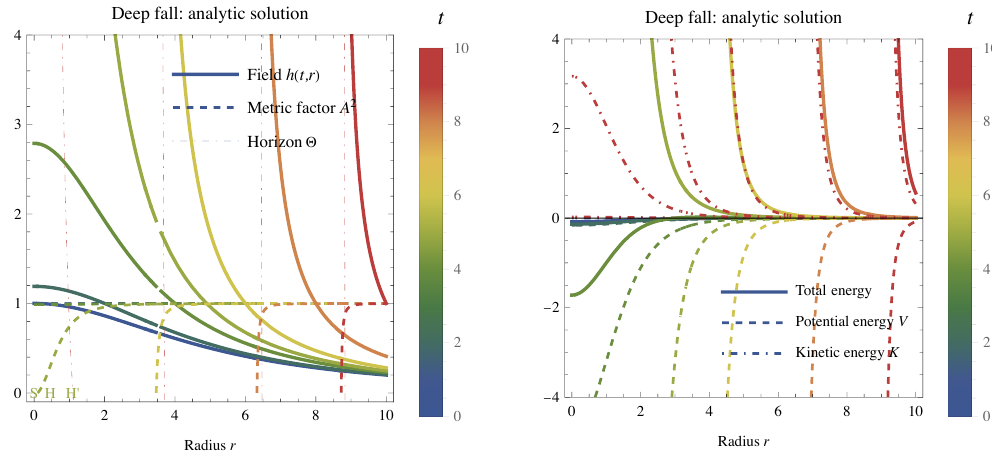
Figure 3 . Evolution in Einstein gravity of the scalar bubble for the potential of eq. (3.2). Left : the field h ( t, r ) , the scale factor A ( t, r ) , and the criterion for horizon formation Θ( t, r ) . An apparent horizon first appears at the point denoted as H. Later a singularity appears inside the horizon at the point denoted as S, while the horizon reaches H 0 . Right : the energy densities. We assumed ¯ h 0 = M Pl / 10 , r 0 = 5 /h 0 and plotted in units in which h 0 = 1